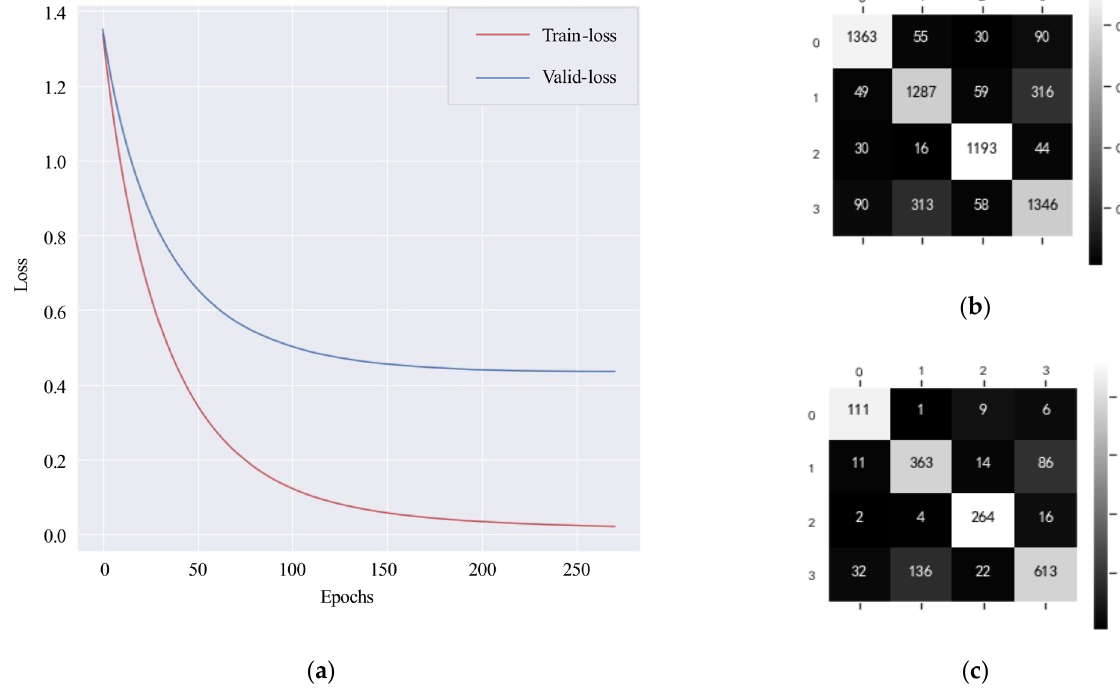
Figure 29. ( a ) Learning curve (XGBoost3); ( b ) Confusion matrix of samples (XGBoost3); ( c ) Confusion matrix of ships (XGBoost3).